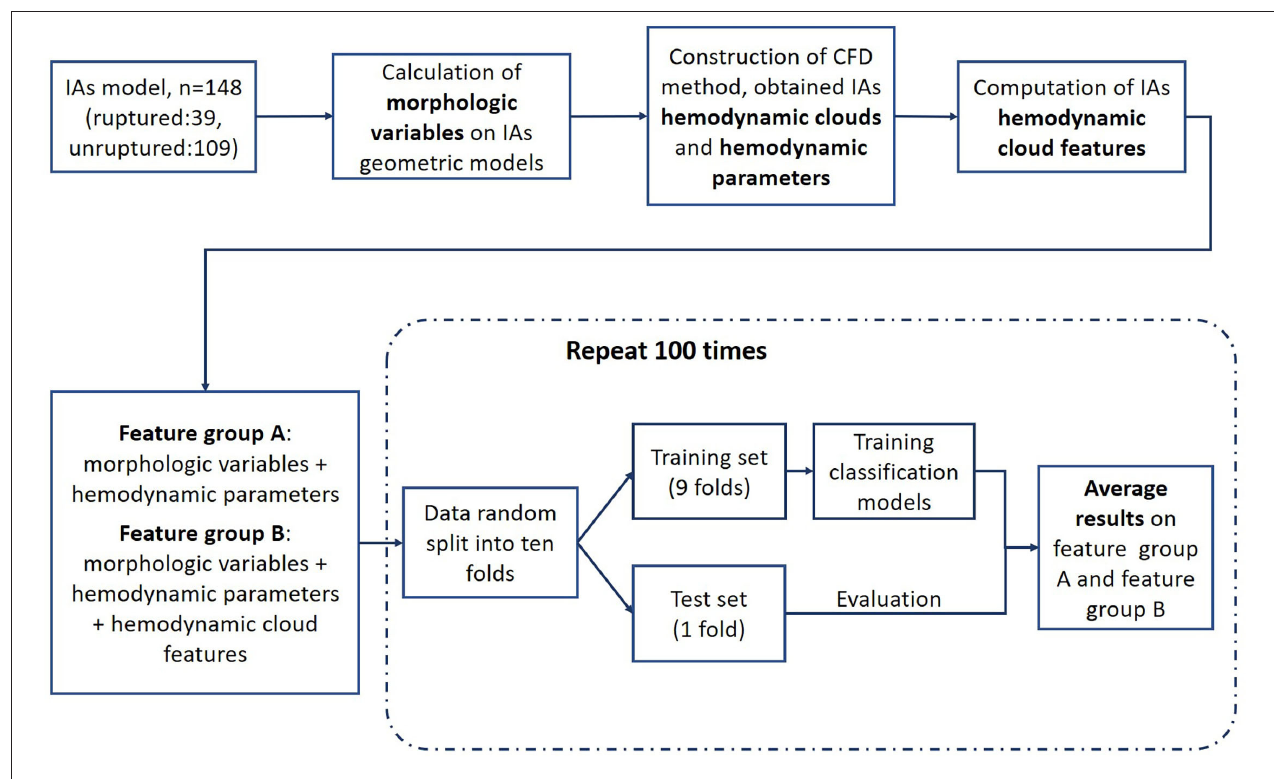
FIGURE 1 | Framework of the integrated model.